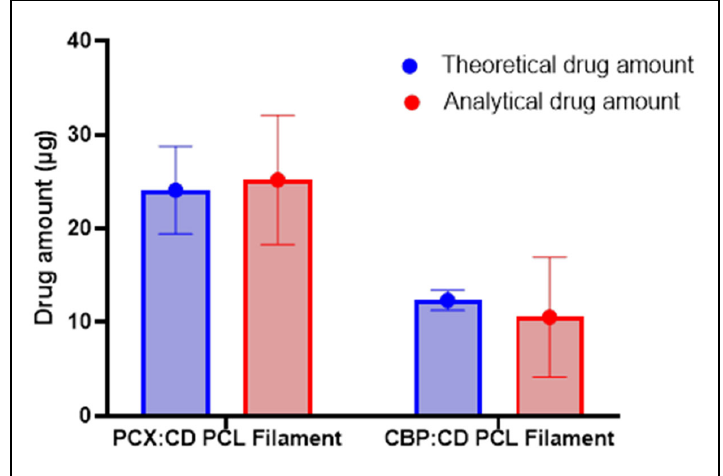
Figure 8. Analytical (red) and Theoretical Drug (blue) amount of PCX:CD PCL Filament and CBP:CD PCL Filament.